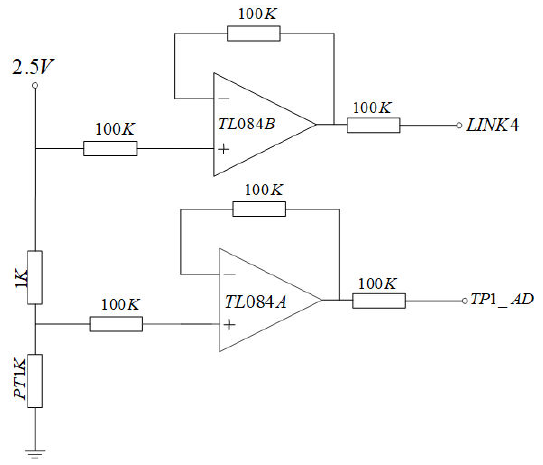
Figure 8. Circuit diagram of the temperature signal processing